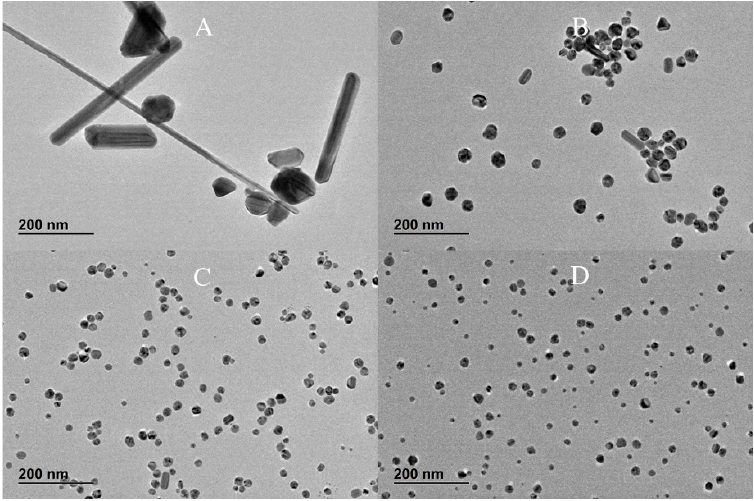
Figure 2. TEM images of AgNPs synthesised at various TA concentrations: ( A ) 0 M, ( B ) 2 × 10 − 8 M, ( C ) 2 × 10 − 7 M and ( D ) 2 × 10 − 6 M.